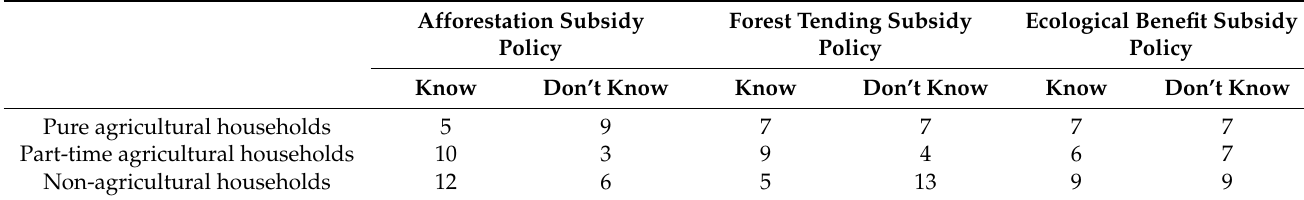
Table 7. Forestland transfer and forestry compensation policies.